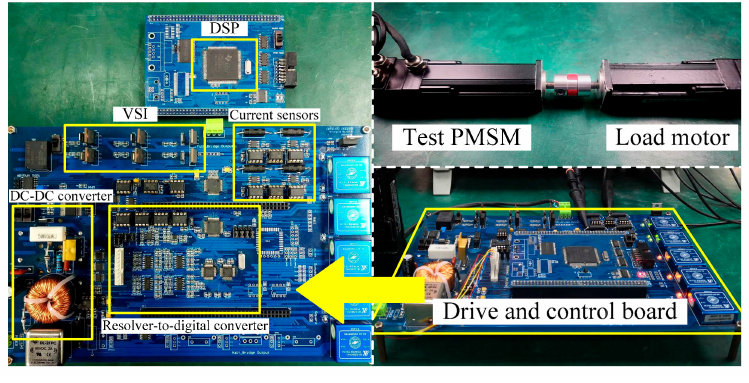
Figure 7. Experimental platform. Table 1. Main parameters of test